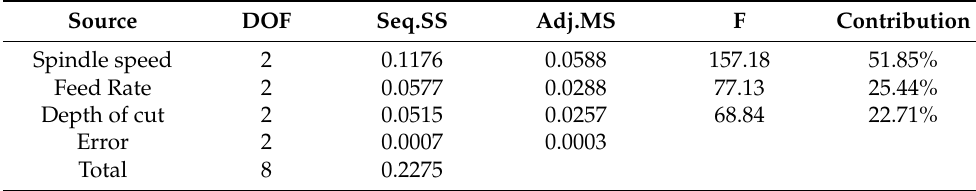
Table 7. ANOVA analysis for surface roughness of 4 ◦ PCD